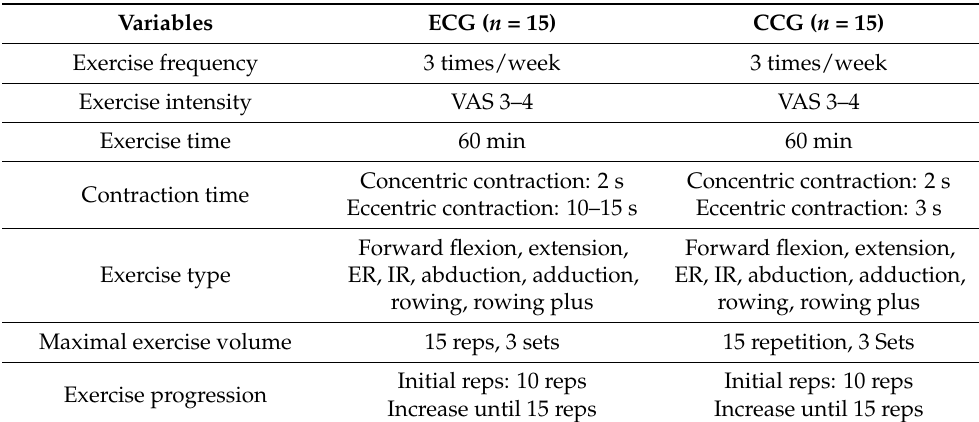
Table 2. The detailed information about the main exercise in the exercise